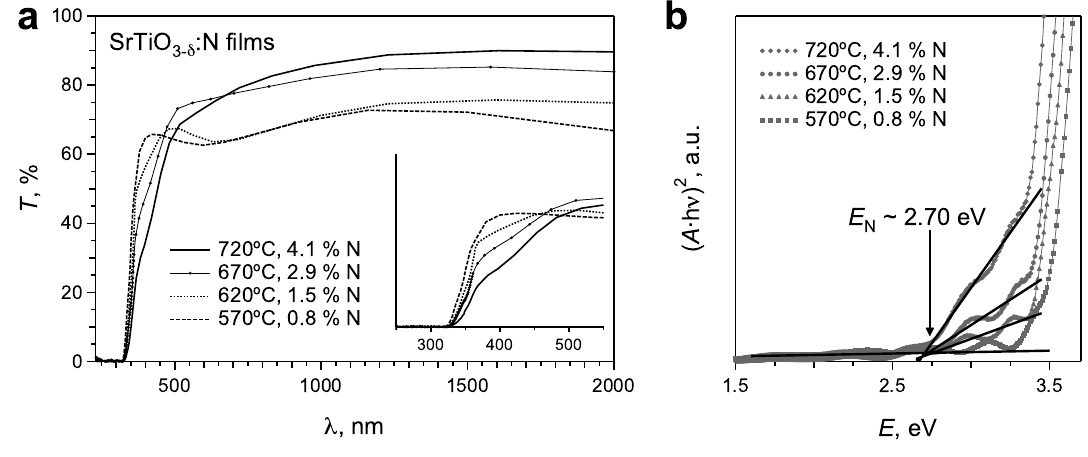
:N films deposited with the ammonia gas Figure 8. ( a ) Transmittance spectra of SrTiO 3 pulse at different substrate temperatures. The insert illustrates the increase of the absorption within the “N absorption shoulder” wavelength region with an increase of the nitrogen content. ( b ) The corresponding Tauc plots for these films. The increase of the nitrogen content to 4.1 at.% does not change the energy of N levels inside the band